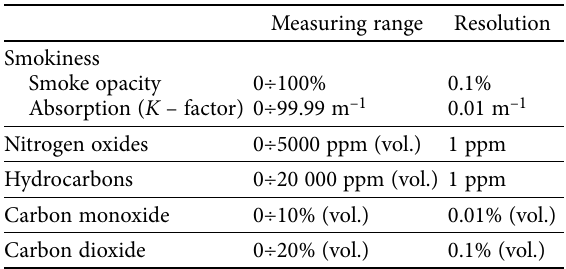
Table 2. The measuring range and accuracy of the device AVL DiCom 4000 Measuring range